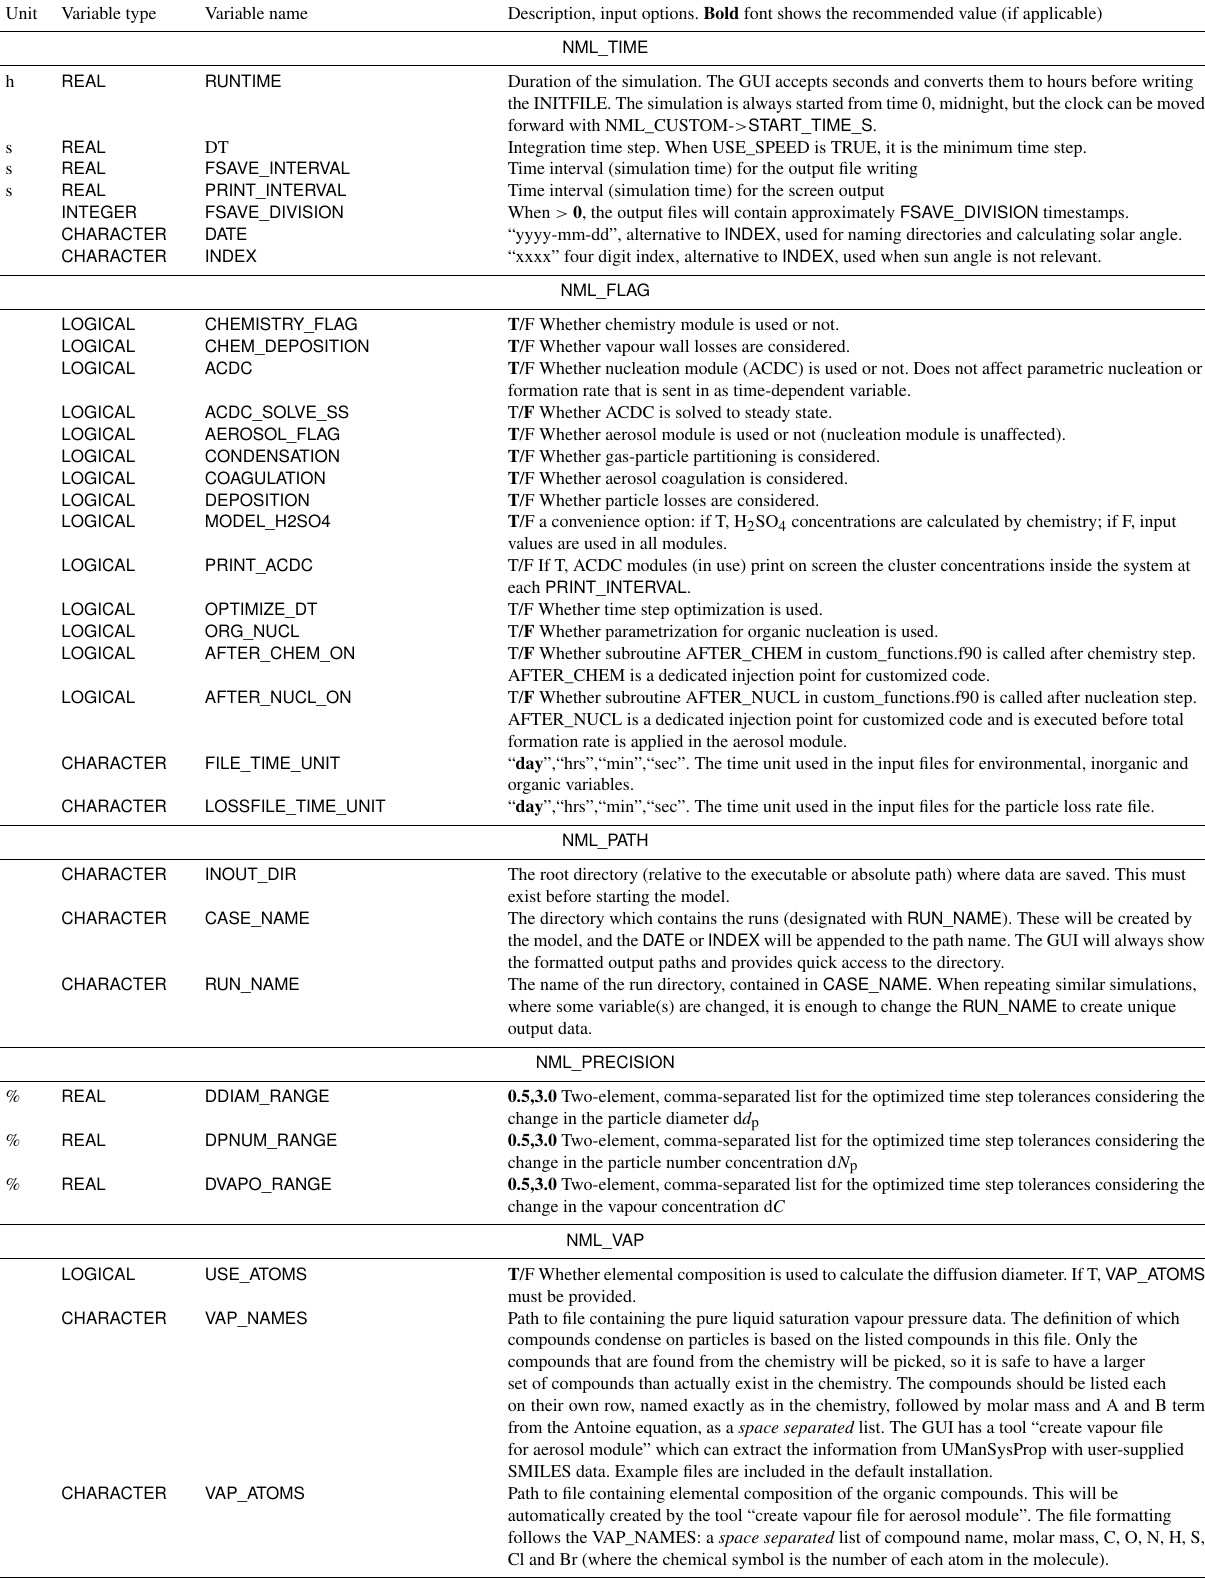
Table A1. Model variables which can be set from the GUI and INITFILE. T and F signify true and false, respectively. Unit Variable